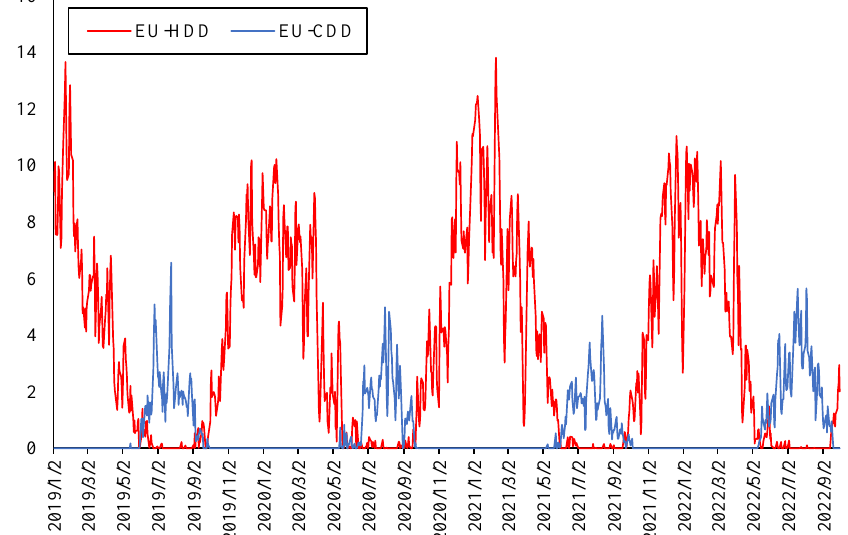
Figure 4. HDD and CDD in Europe.